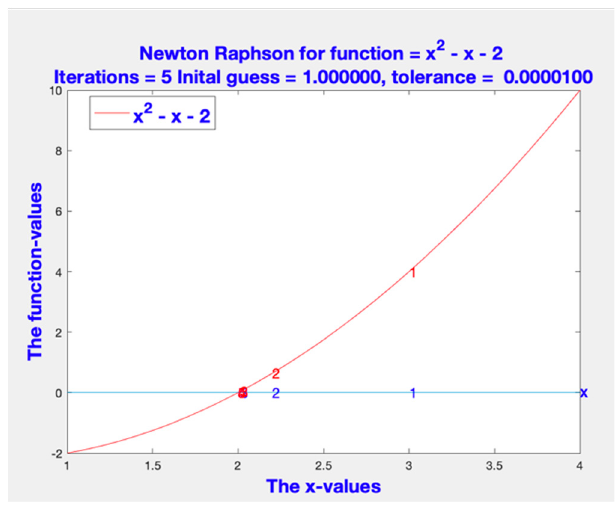
Figure 8. Plot of Newton–Raphson algorithm execution.